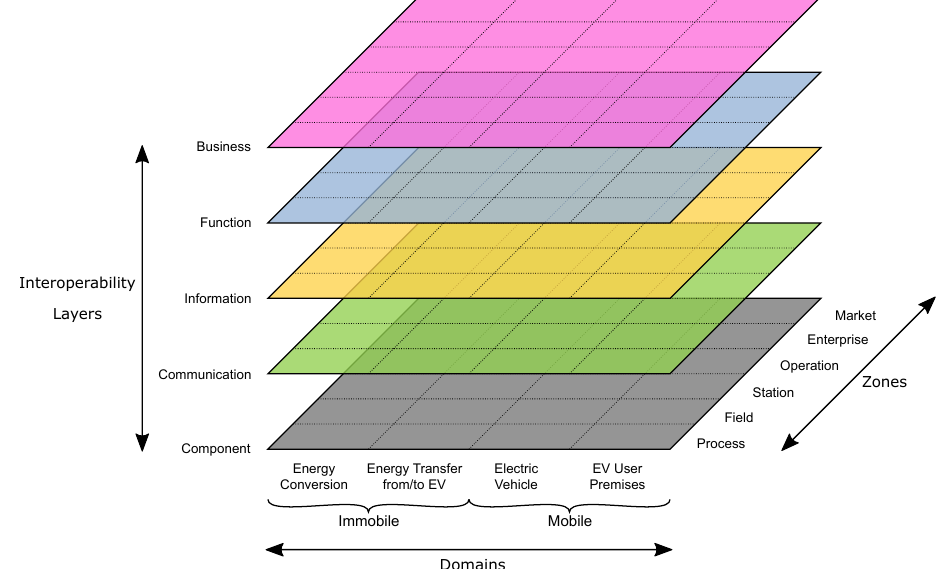
Figure 1. The E-Mobility Systems Architecture (EMSA) model of